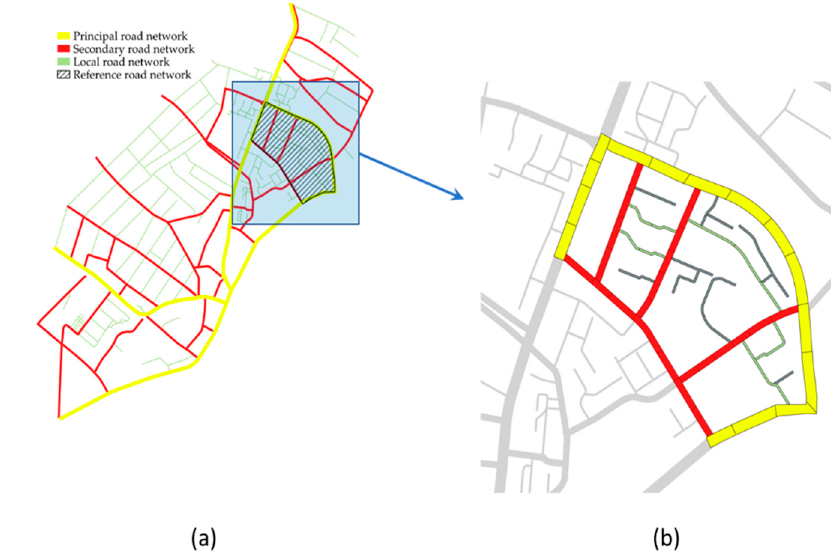
Figure 2. Road Network: ( a ) entire network ( b ) reference network.